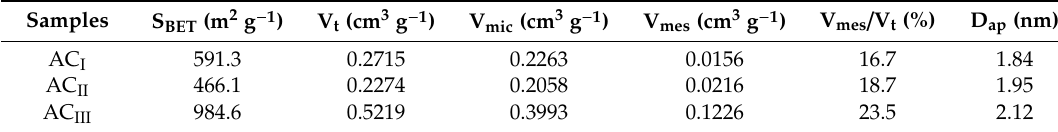
Table 1. The pore structure parameters of TXA and